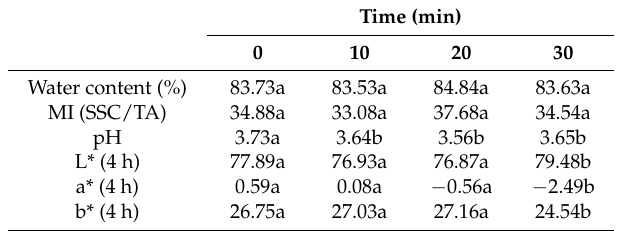
Table 1. Physico-chemical parameters of Pink Lady apples, as affected by plasma treatment